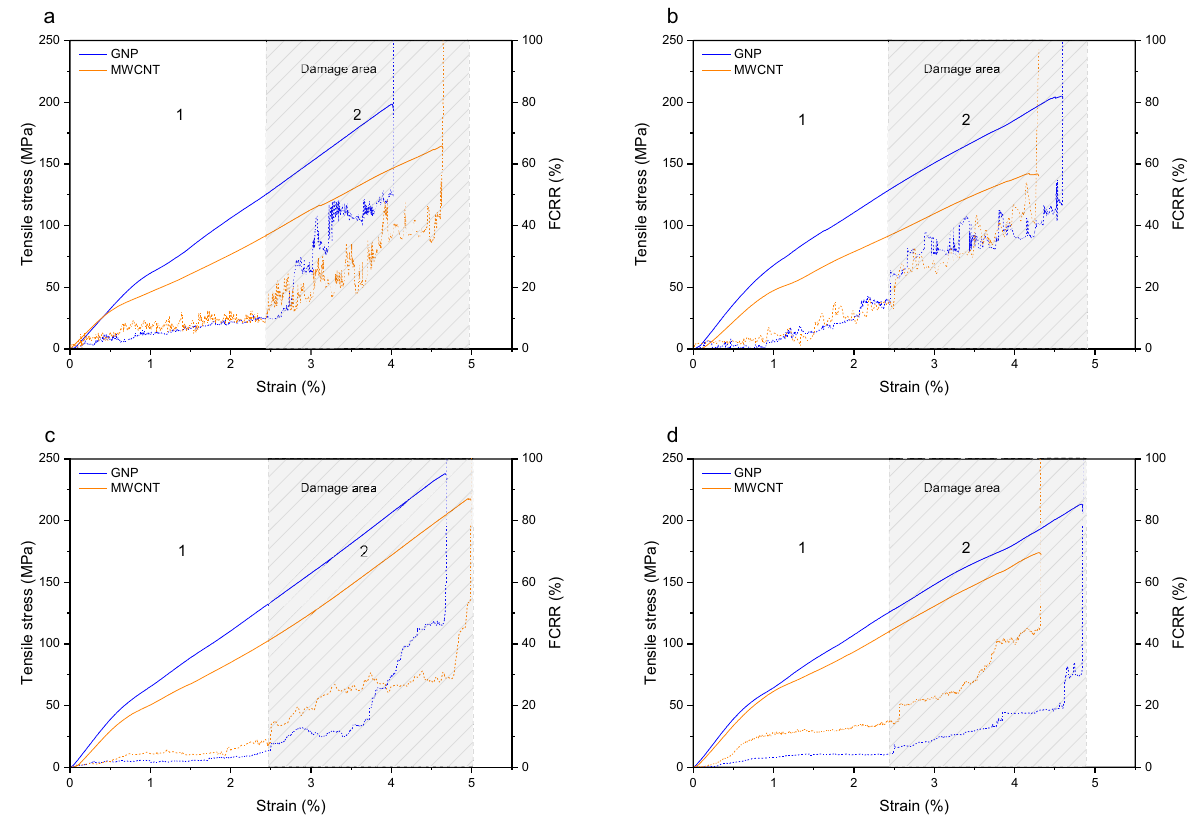
Figure 3: Tensile stress and FCRR as a function of strain in GNP - glass and MWCNT - glass composites: ( a ) 0.5, ( b ) 1.5, ( c ) 3, and ( d ) 5